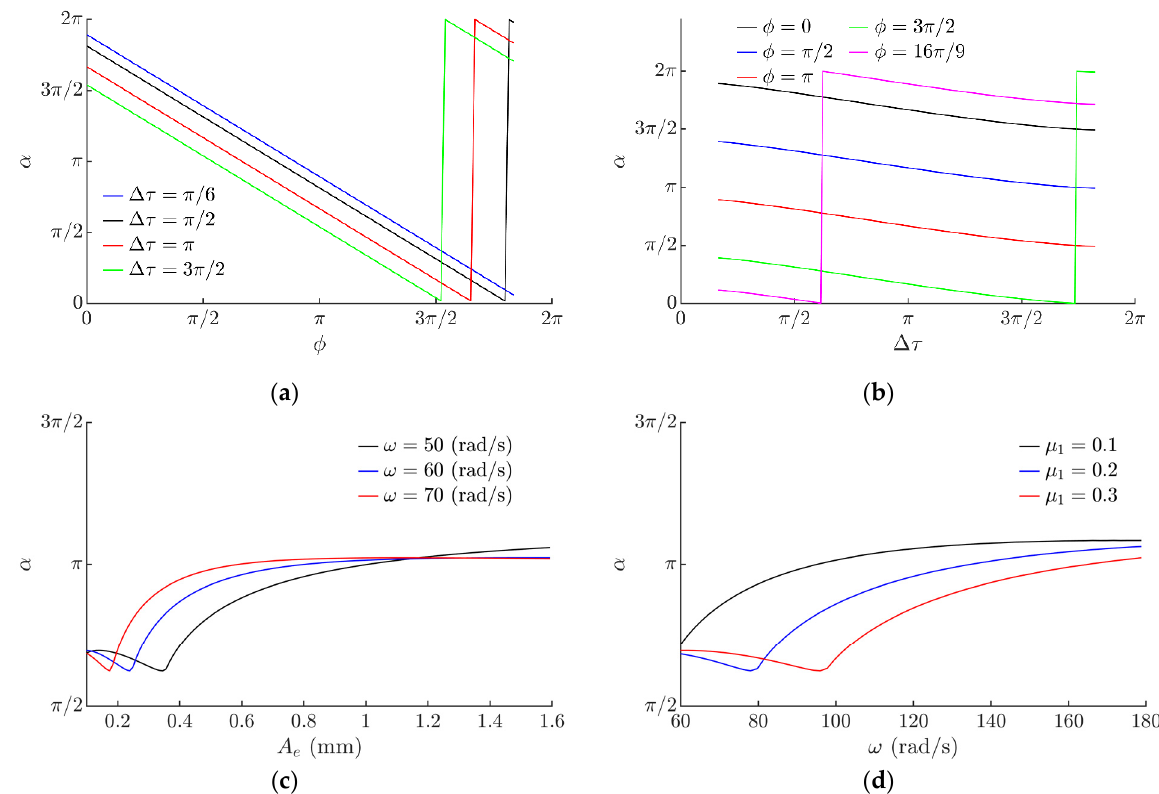
Figure 7. The displacement angle α depending on: ( a ) phase shift ϕ when μ 1 = 0.1, μ 2 = μ 1 /8, g = 9.81 m/s 2 , A e = 0.28 mm, ω = 62.8 rad/s, ε = π /2; ( b ) Δ τ when μ 2 = μ 1 /8, g = 9.81 m/s 2 , A e = 0.28 mm, ω = 62.8 rad/s, ε = π /2; ( c ) excitation amplitude A e when μ 1 = 0.1, μ 2 = μ 1 /8, g = 9.81 m/s 2 , ε = π /2, ϕ = π /2, Δ τ = 2 π /3; ( d ) excitation frequency ω when μ 2 = μ 1 /8, g = 9.81 m/s 2 , ε = π /2, A e = 0.28 mm, ϕ = π /2, Δ τ = 2 π /3.